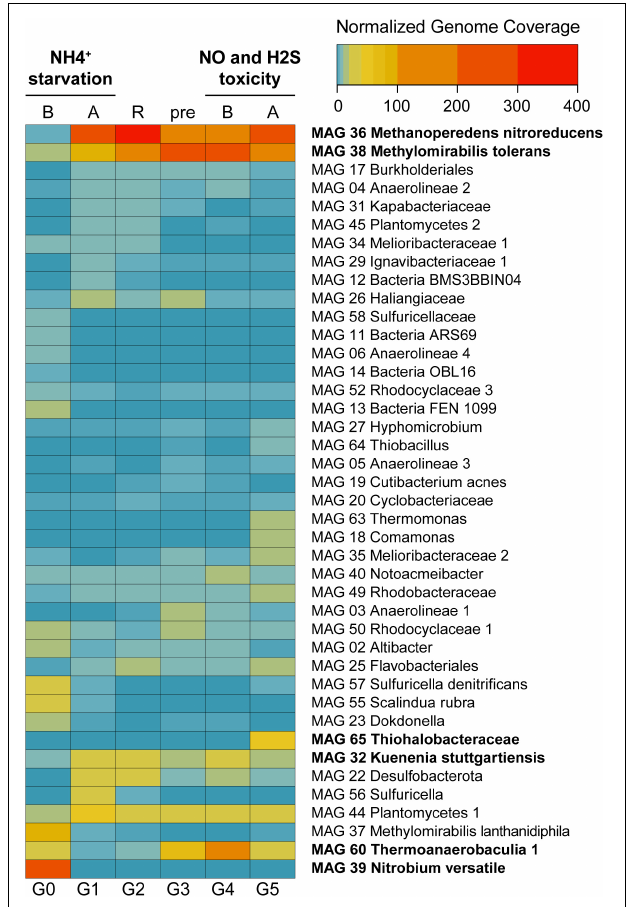
FIGURE 3 | Heat map displaying normalized genome coverage for the most abundant MAGs across experimental conditions. Abbreviations are as follows: B, before; A, after; R, recovery; pre, preparatory phase. Experiments are indicated in bold on top. MAGs are ordered based on normalized genome coverage values and abundance change patterns. Between 91 and 95% of the reads were assembled and mapped to the MAGs across all experimental time